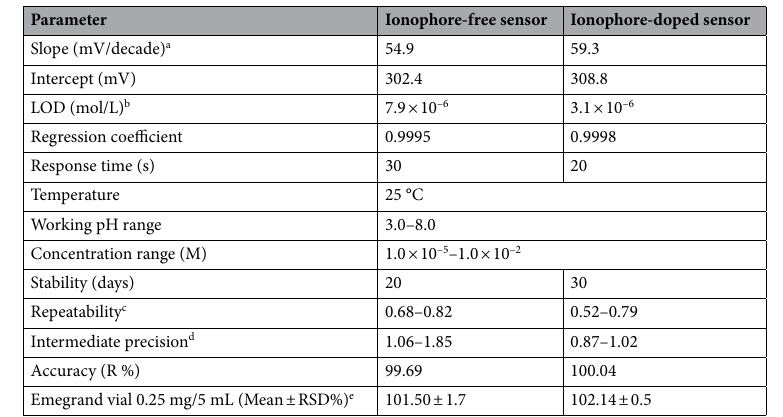
Table 1. Electrochemical response characteristics of the investigated PALO sensors. a Average of four determinations. b Limit of detection calculated at the interception of extrapolated arms in potential profile. c The intraday (n = 3) RSD% of concentrations 10 –2 , 10 –3 and 10 –4 M PALO. d The interday (n = 3) RSD% of concentrations 10 –2 , 10 –3 and 10 –4 M PALO. e The average of five